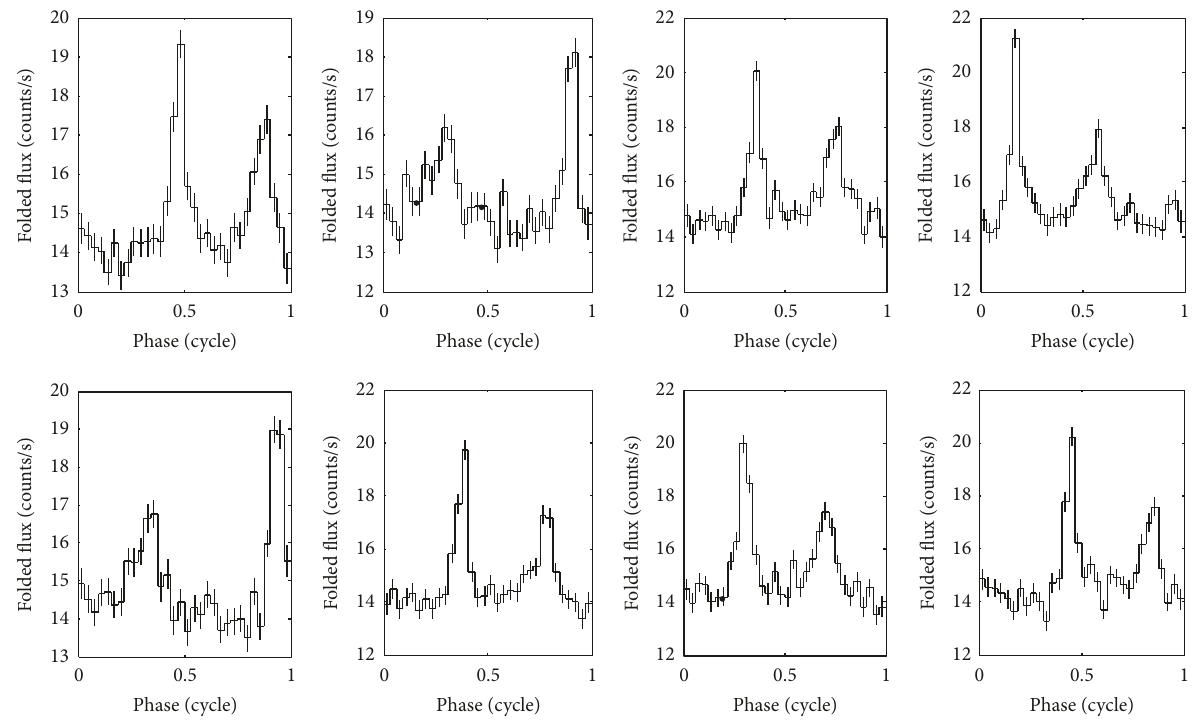
Figure 6: Crab profiles in the 0.5 ∼ 9 keV band from eight observations from UTC 57803.5 MJD to UTC 57812.6